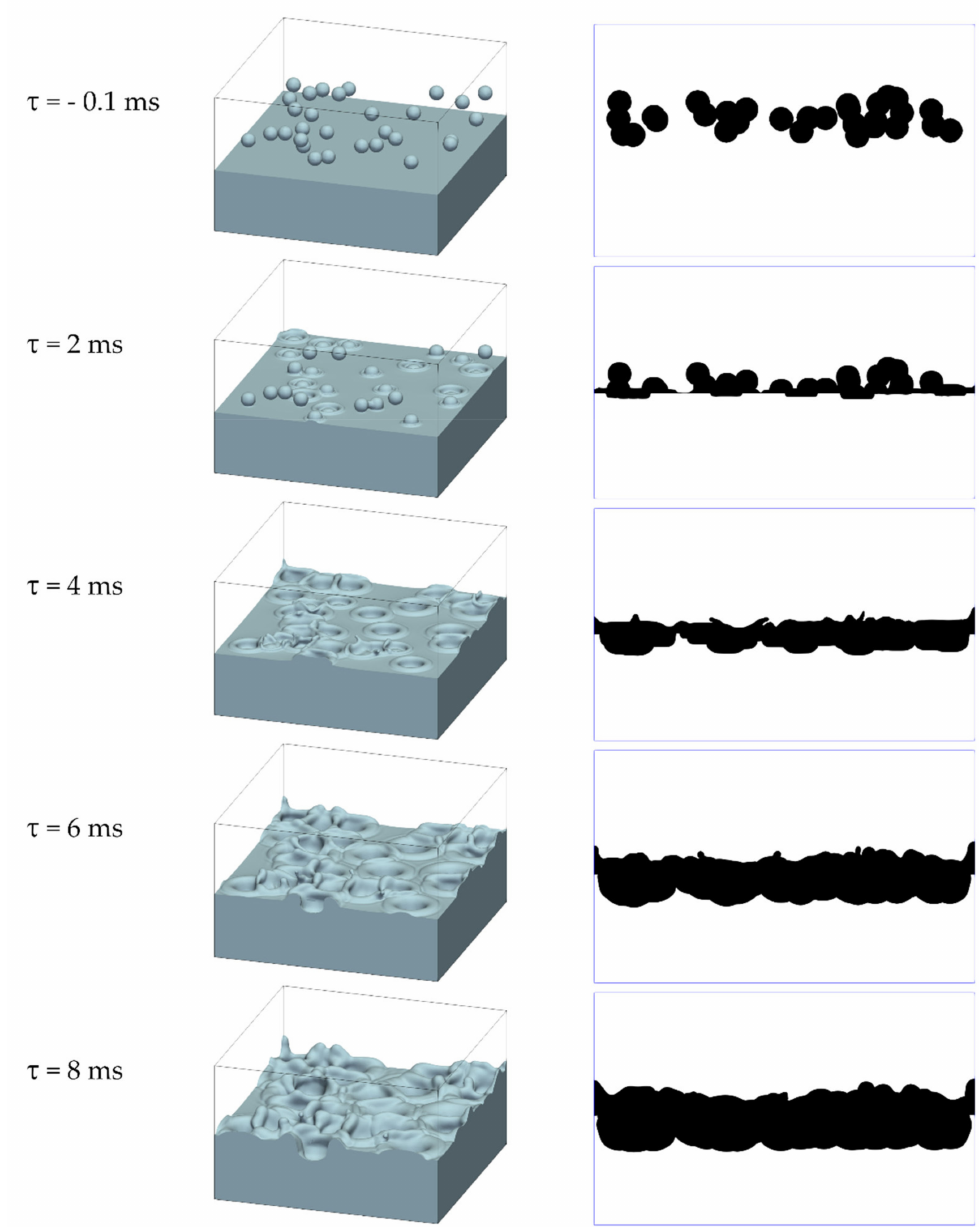
Figure 4. Examples of frames (3D and 2D used to extract the crater depth) showing the evolution of the craters and of the free surface of the pool for a case of multiple drop impacts with 30 drops, impact velocity 1.4